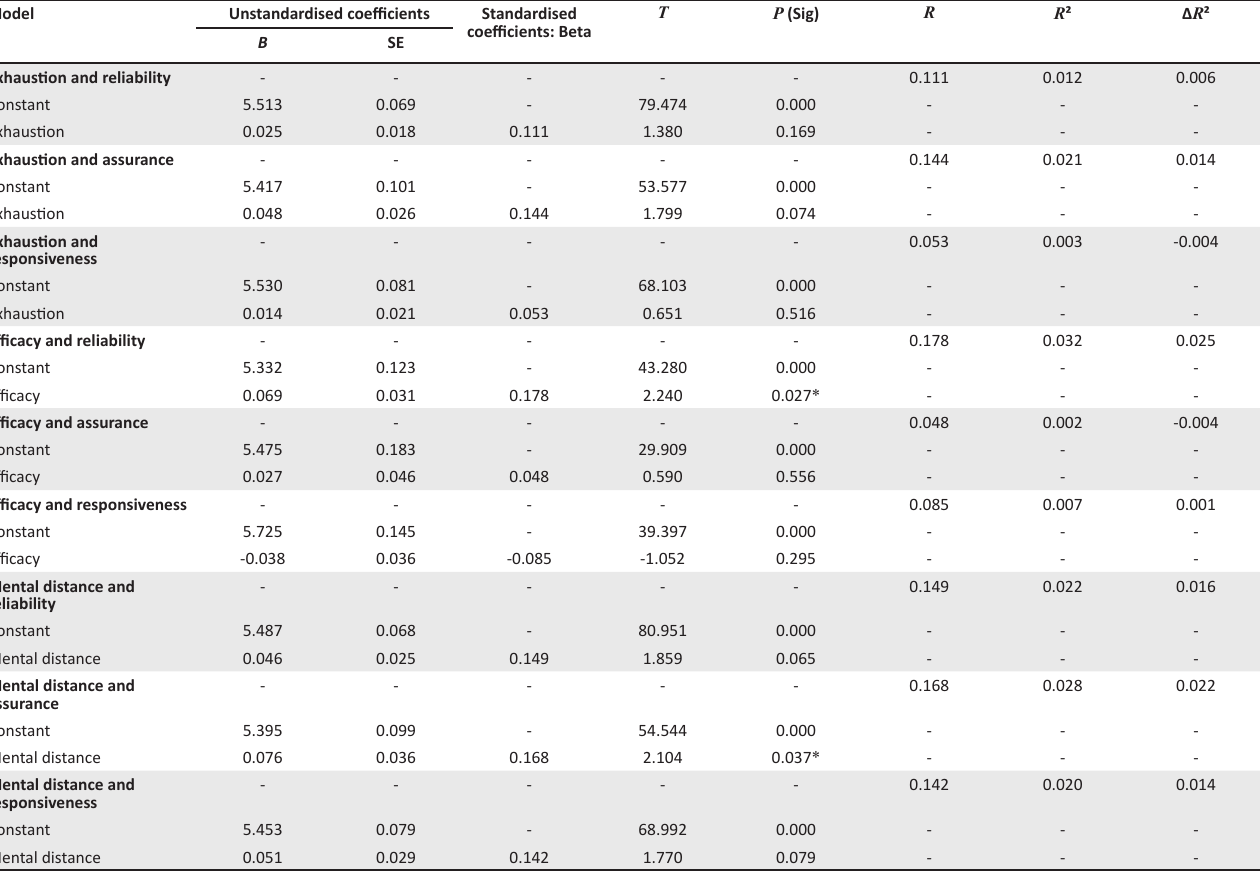
TABLE 4: Regression analyses of burnout and service quality orientation. Model